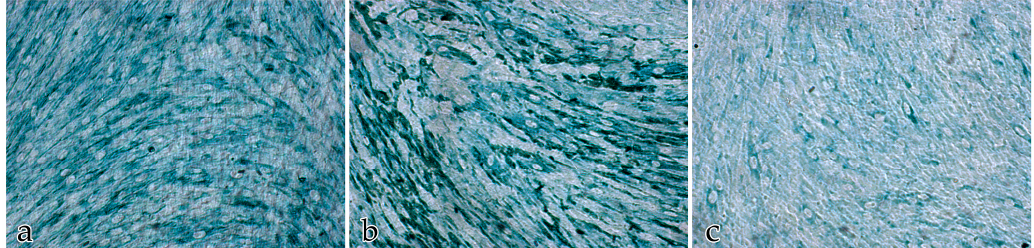
Figure 8. Immunolocalization of the ECM proteins collagen III, fibronectin, and laminin in cocultures of FBs and ECs after 14 days: ( a ) immunolocalization of collagen III; ( b ) immunolocalization of fibronectin; ( c ) immunolocalization of laminin. Magnification ×20.